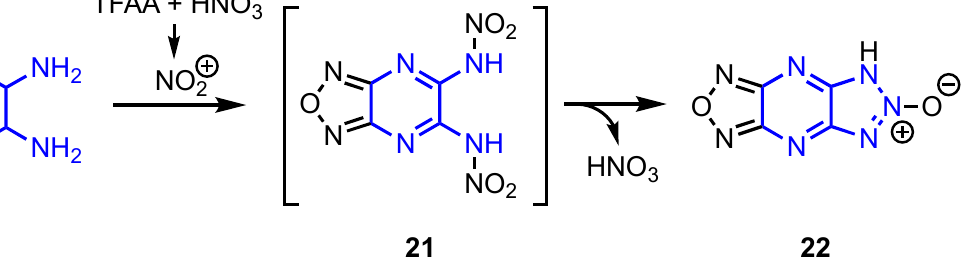
Scheme 3. Formation of triazolopyrazine N-oxide 22 from diaminopyrazine 20 , proceeding via intermediate 21 .